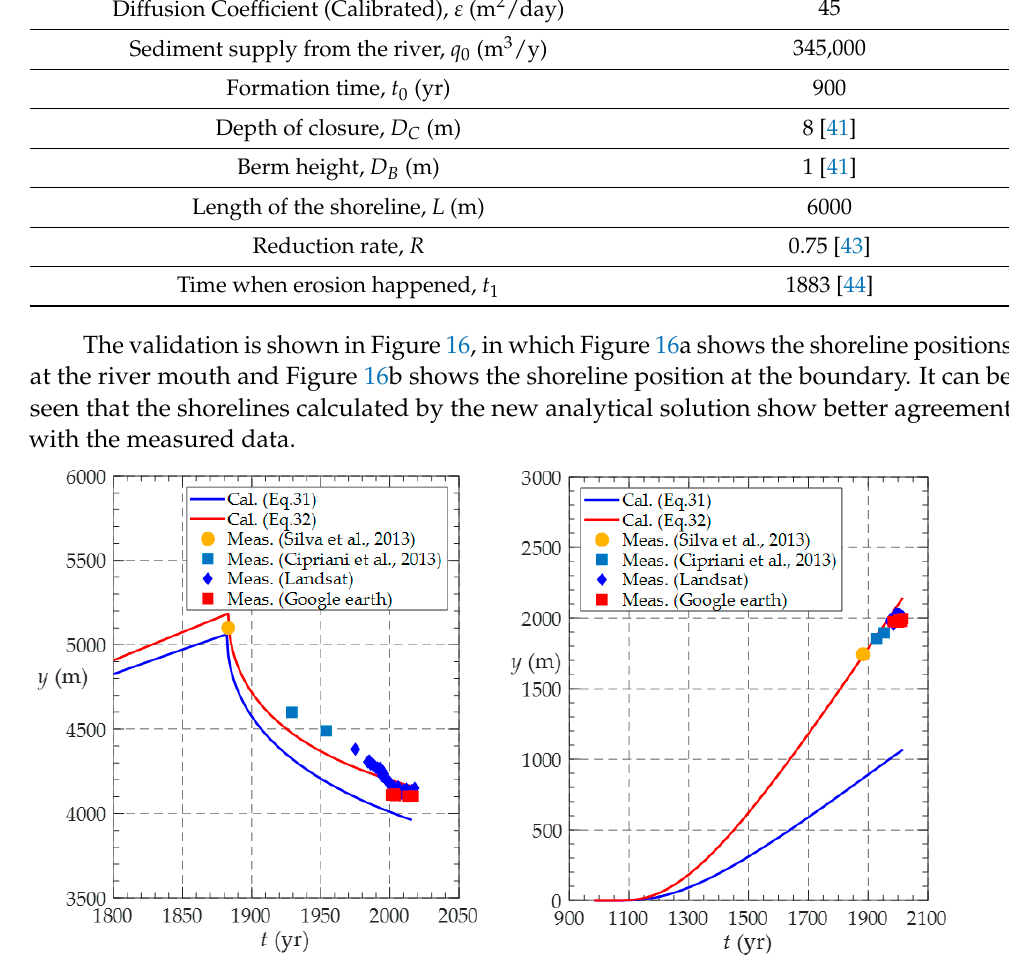
Table 3. Calibrated values determined from the fitting process for the Ombrone River delta.